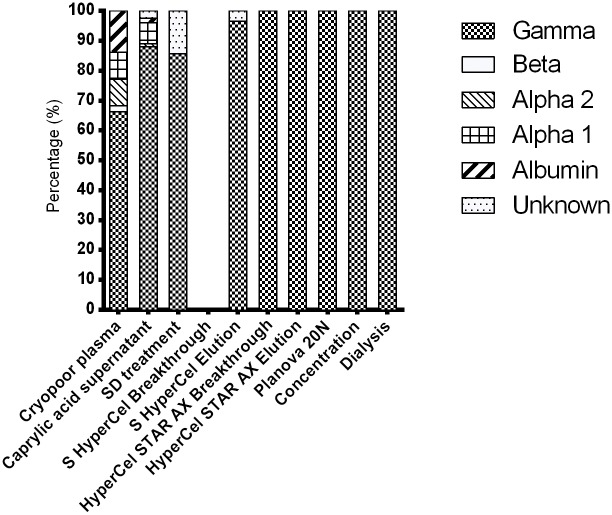
Densitometric analysis of the zone electrophoresis of fractions generated throughout the purification process showing the relative proportions of proteins migrating as gamma, beta, alpha-2, and alpha-1 proteins, and albumin.